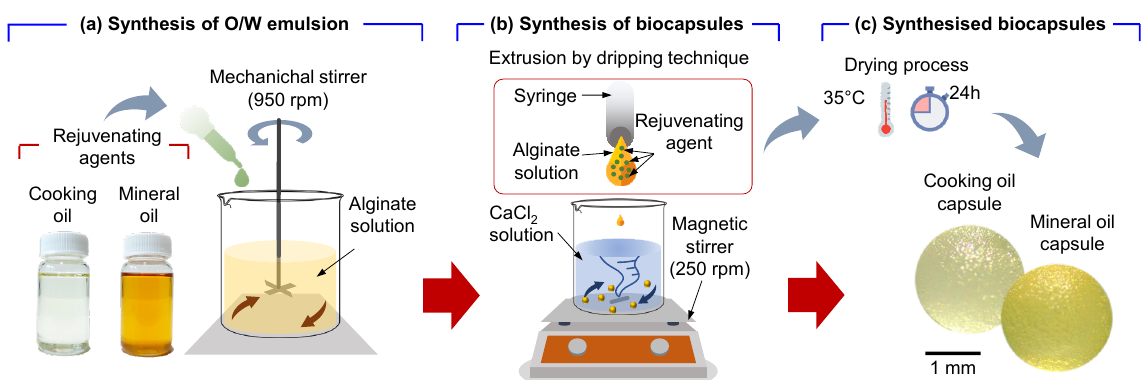
Figure 2. Representation of the synthesis of the: (a) CO and MO emulsions; and (b) CO and MO biocapsules. (c) Synthesised CO and MO biocapsules. The encapsulation efficiency